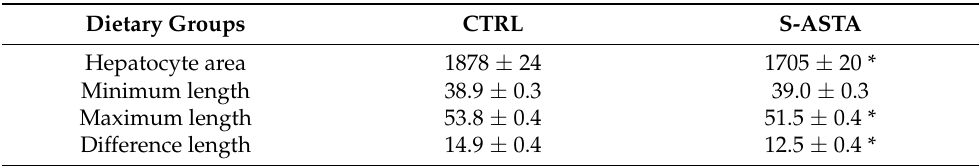
Table 3. Hepatocyte morphometry of rainbow trout fed a diet without (CTRL) and with astaxanthin (S-ASTA) for 12 weeks. Dietary Groups CTRL S-ASTA Hepatocyte area